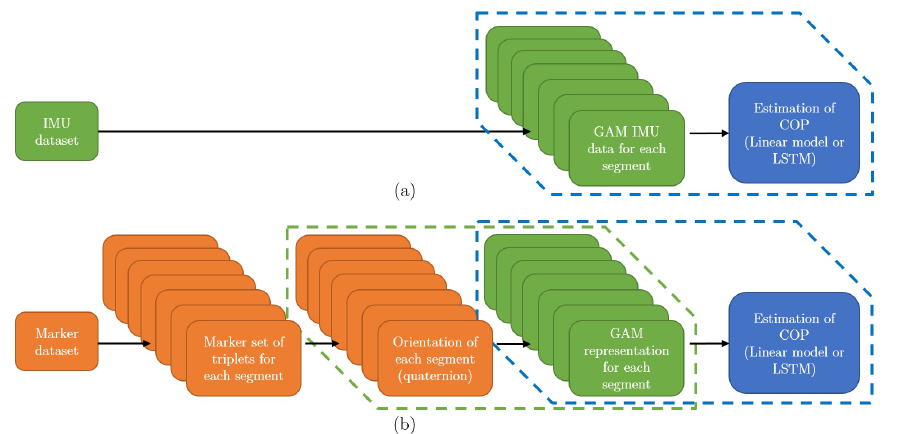
dataset. Subfigure ( a ) shows the steps for estimating COP from IMU data. IMU dataset is divided into data consisting of a gyroscope, accelerometer, and magnetometer (GAM) raw signals for each segment. This data is then fed into algorithm for estimating COP. Subfigure ( a ) is added to this figure as a comparison to show which are additional steps required for estimating COP from public dataset which are shown in subfigure ( b ). Marker data from public dataset are divided into marker triplets attached to particular human body segments and are used to calculate the orientation of each segment. Orientation of each segment is represented in quaternion form. In next step, a quaternion form representation of orientation of each segment is converted into GAM form. This form allows the use of same algorithms for estimating the COP as in case of using IMU data. A more detailed block diagram for steps framed by green dashed line are shown in Figure 4. A more detailed block diagram for steps framed by blue dashed line for estimating COP from GAM data (IMU or GAM representation for public dataset) is shown in Figure